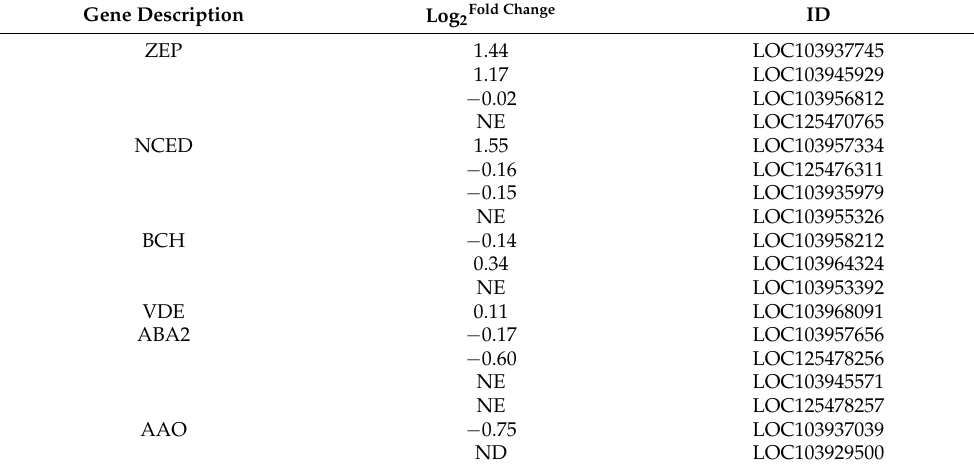
Table 3. Expression levels of ABA synthesis genes. NE refer to not expressed.